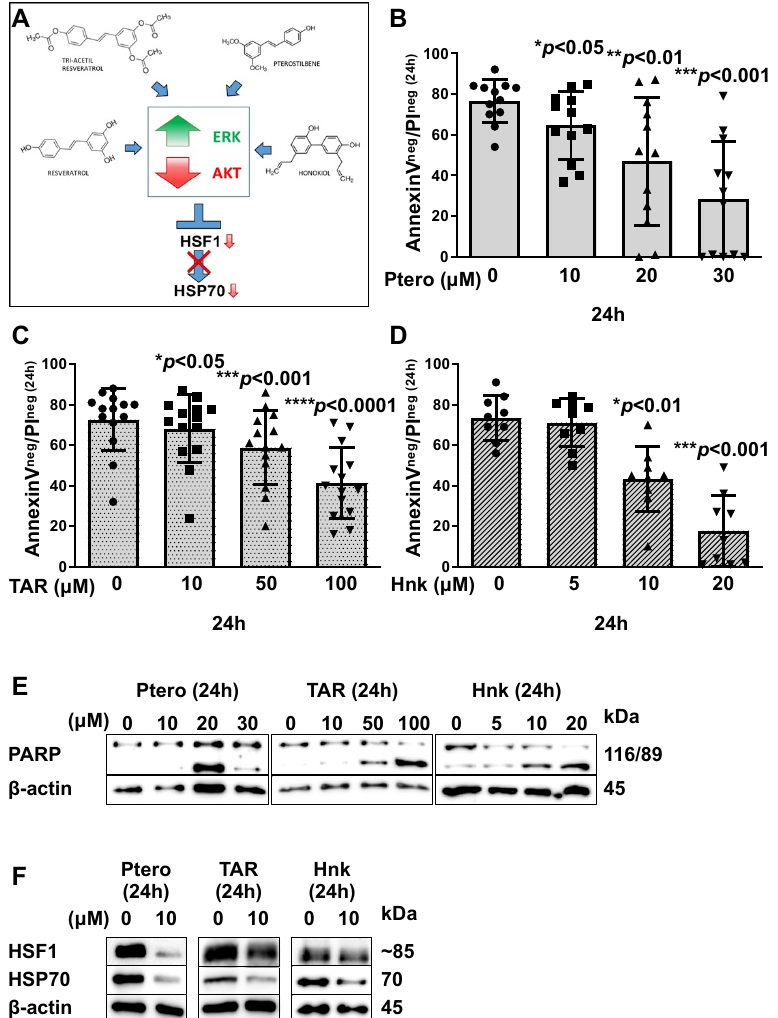
Figure 2. Pterostilbene, triacetyl resveratrol and honokiol induce apoptosis in CLL leukemic B cells. ( A ). Chemical structures of resveratrol, pterostilbene, triacetyl resveratrol and honokiol, and a schematic way of their action on ERK and AKT activation, and finally on HSP70/HSF1 axis. ( B ). Cells were cultured alone or in the presence of 10, 20 or 30 µ M Ptero and cell apoptosis were analyzed by annexin V-PI flow cytometric test. Histograms report the percentage of annexin V neg /PI neg cells after 24 h treatment. Data are reported as mean ± SD (* p < 0.05, ** p < 0.01 and *** p < 0.001 vs. the untreated condition, paired Student’s t test; n = 12). ( C ). Cells were cultured alone or in the presence of 10, 50 or 100 µ M TAR and cell apoptosis were analyzed by annexin V/PI flow cytometric test. Histograms report the percentage of annexin V neg /PI neg cells after 24 h treatment. Data are reported as mean ± SD (* p < 0.05, *** p < 0.001 and **** p < 0.0001 vs. the untreated condition, paired Student’s t test; n = 14). ( D ). Cells were cultured alone or in the presence of 5, 10 or 20 µ M Hnk, and cell apoptosis was analyzed by annexin V-PI flow cytometric test. Histograms report the percentage of Annexin V neg /PI neg cells after 24 h treatment. Data are reported as mean ± SD (*** p < 0.001 and **** p < 0.0001 vs. the untreated condition, paired Student’s t test; n = 9). ( E ). Lysates obtained from CLL B cells cultured for 24 h alone or with drug concentrations listed in previous points B., C., and D., were analyzed by immunostaining with anti-PARP, for apoptosis detection, and anti- β -Actin as loading control. Western blotting is representative of all the cases analyzed. ( F ). Lysates obtained from CLL B cells cultured for 24 h alone or with 10 µ M Ptero, 10 µ M TAR and 10 µ M Hnk were analyzed by immunostaining with anti-HSP70, anti-HSF1 and anti- β -Actin as loading control. Western blotting is representative of all the cases analyzed. Ptero: pterostilbene; TAR: triacetyl resveratrol; Hnk: